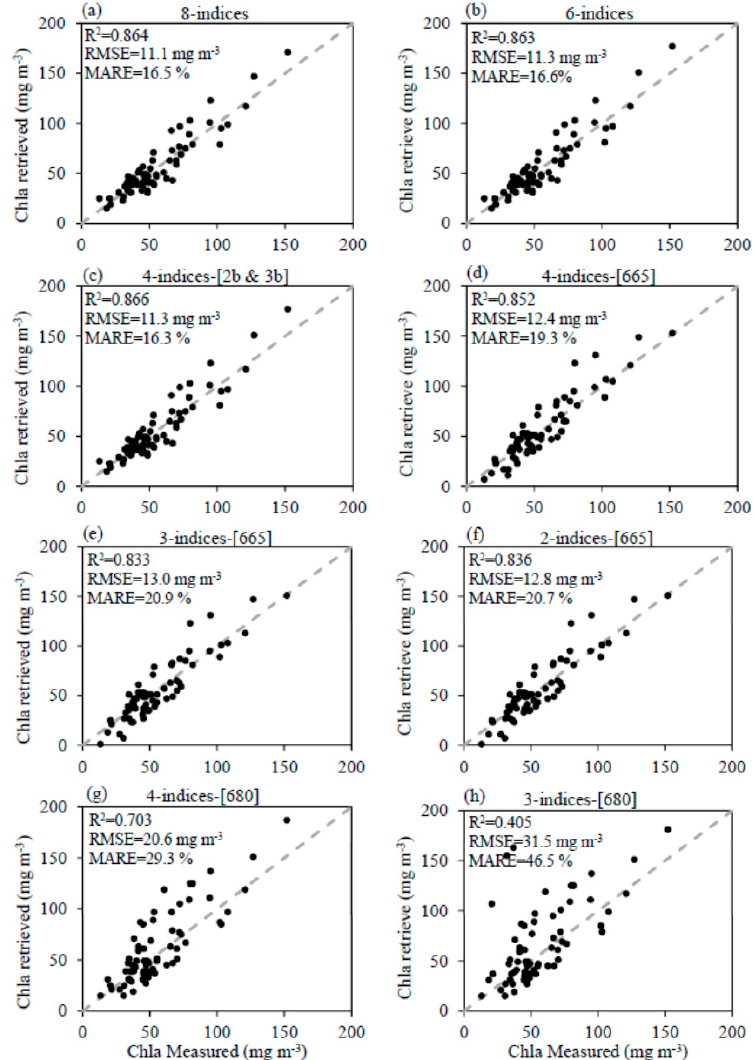
Figure 7. Validation plots between Chla measured in Lake Kasumigaura (68 stations collected in 2016) and retrieved Chla from different algorithms’ combinations assessed for MAIN-LUT. Algorithms used in each combination from ( a ) to ( h ) were mentioned in Table 4.